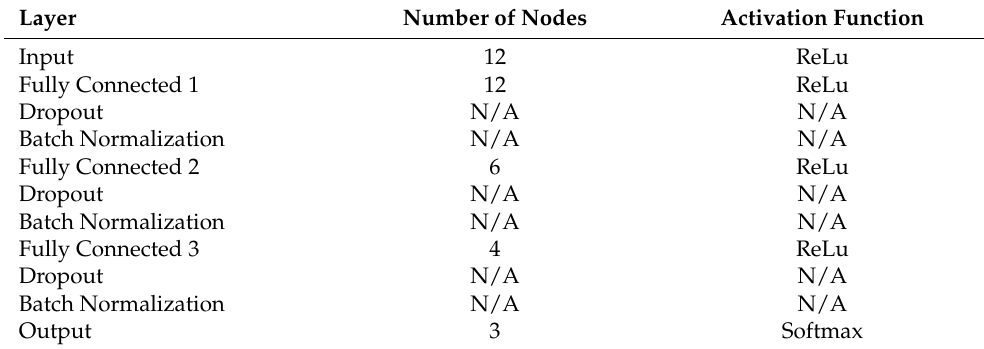
Table 3. Architecture of the final simplified MLP